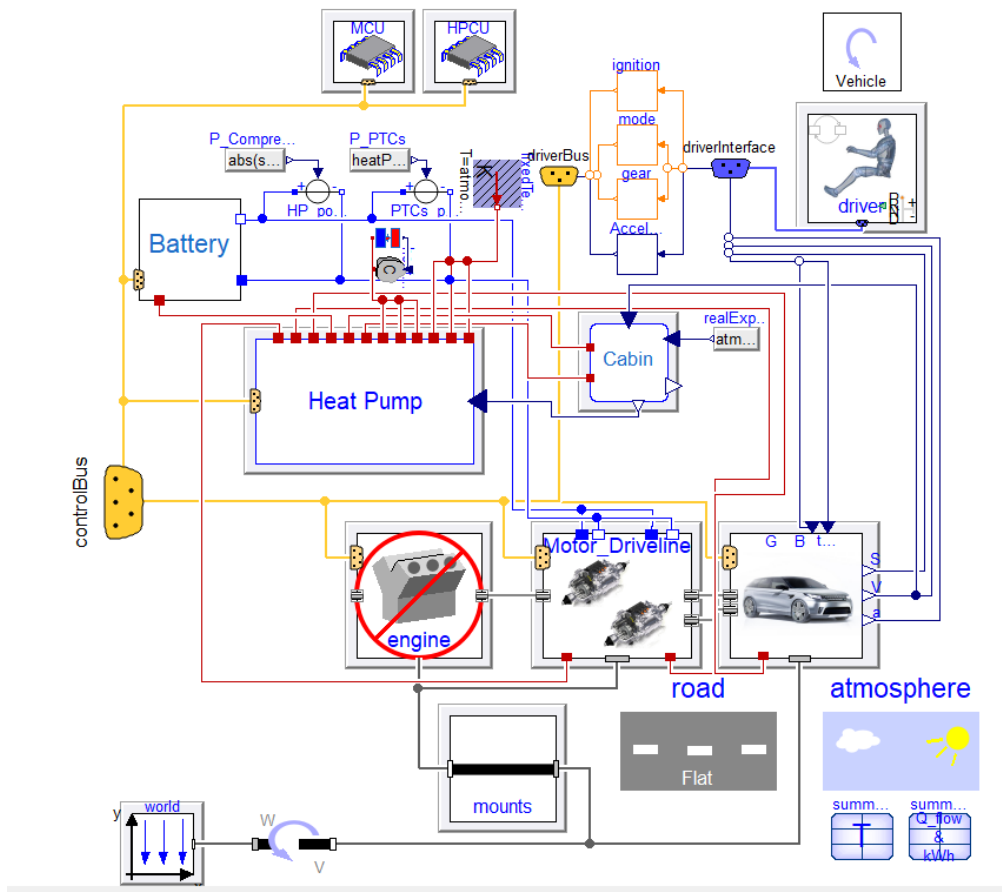
Figure 1. Top level schematic diagram of Dymola vehicle simulation for an